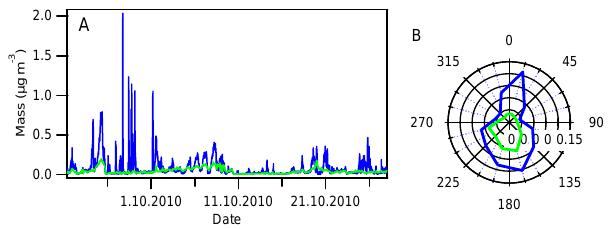
Figure 10. (a) Time series and (b) wind roses of the inorganic ni- Figure 10. (A) Time series and (B) wind roses of the inorganic nitrate (blue) and organic 12 trate (blue) and organic nitrate (green) particulate mass concentra- nitrate (green) particulate mass concentrations calculated from Eq.(1) and (2) . 13 tions calculated from Eq. (1) and